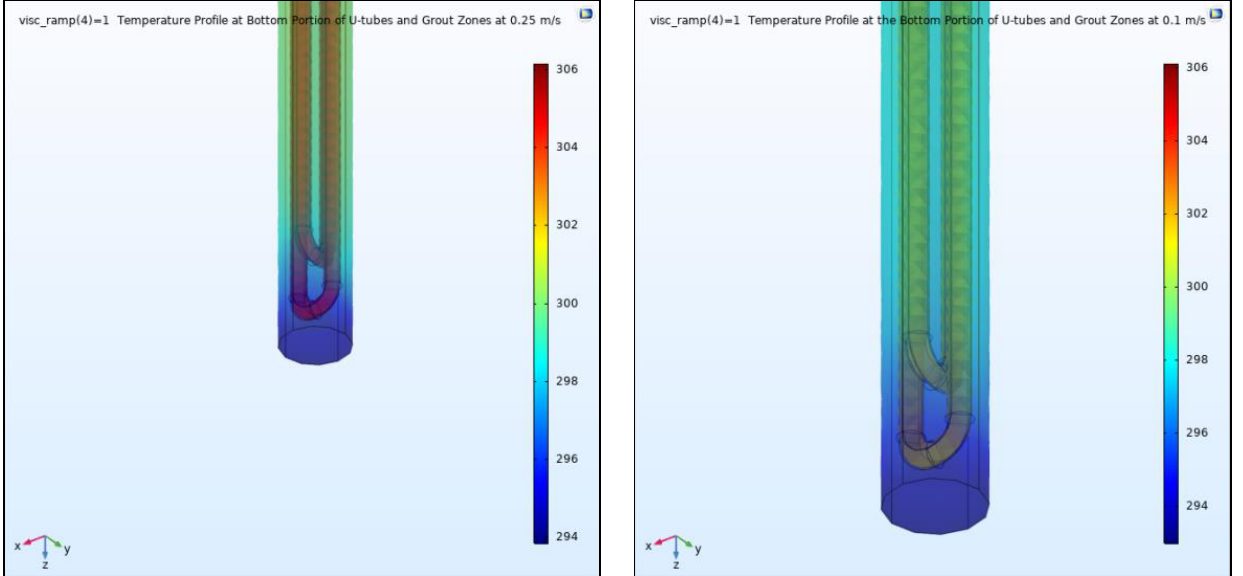
Figure 10.a. Water velocity of (0.25) m/s Figure 10.b. Water velocity of (0.1) m/s Figure 10. Temperature distribution at the double U-tube and grout for various flow